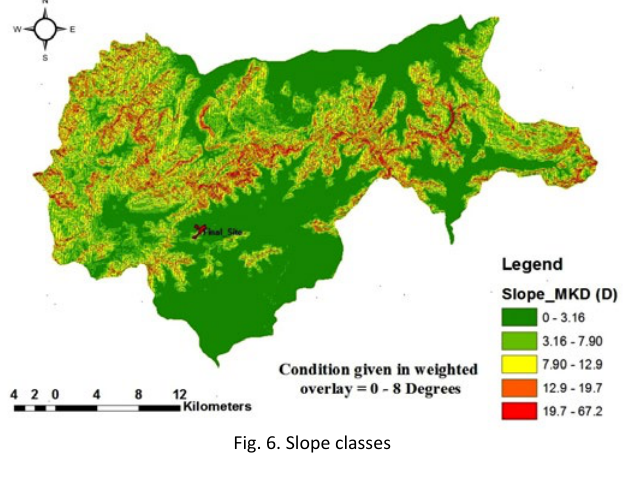
Fig. 5. Rainfall distribution of study area Fig. 5: Rainfall distribution of study area